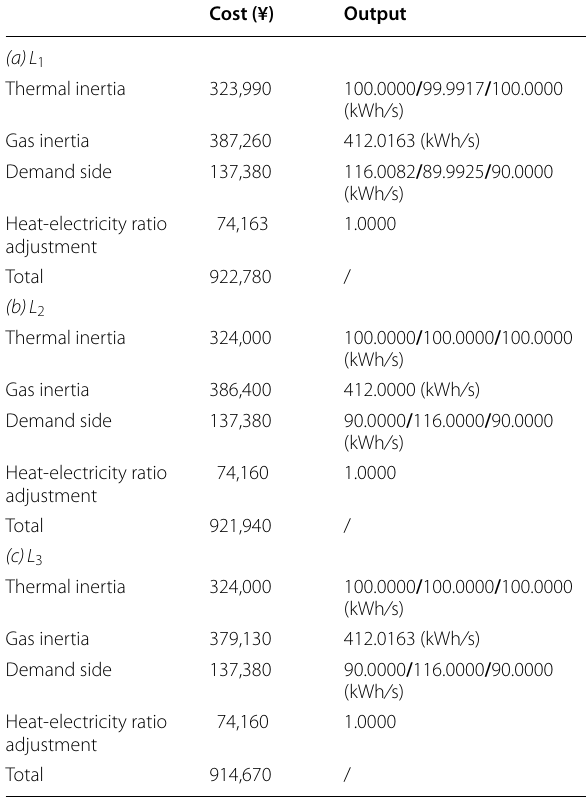
Table 7 Costs and outputs of power forms with power shortages of 500 kWh / s at L 1 −